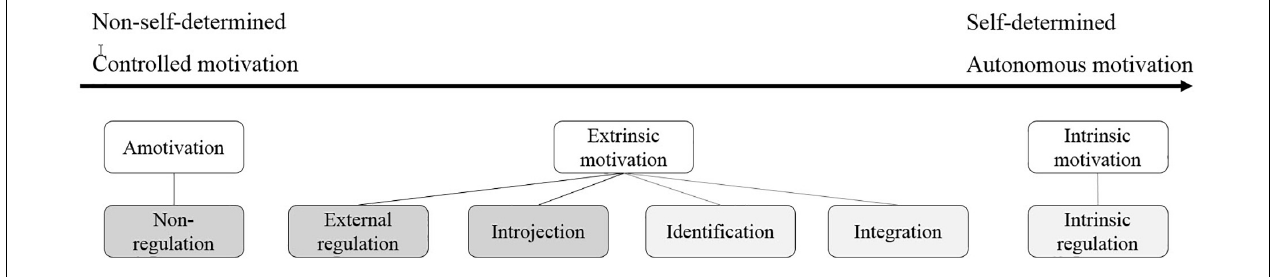
FIGURE 2 | Self-determination theory adapted from Ryan and Deci